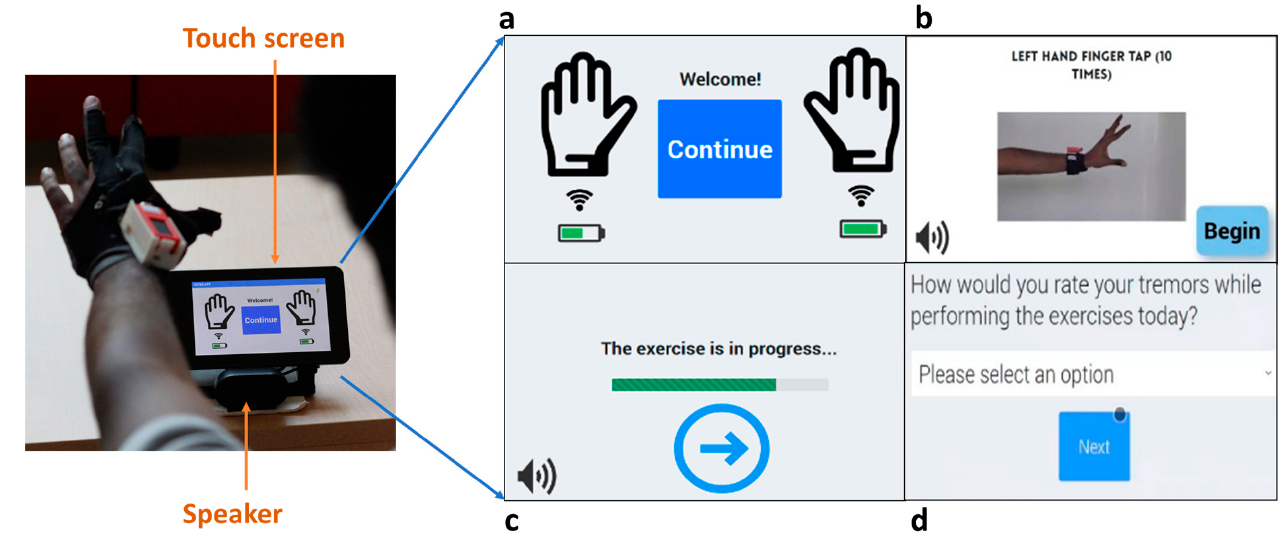
Figure 4. Patient-centered interface: ( a ) Welcome screen with battery status; ( b ) Audiovisual instruc- tion for movement task; ( c ) Movement task timer with the prompt to end task upon early completion; ( d ) Daily symptom questionnaire.